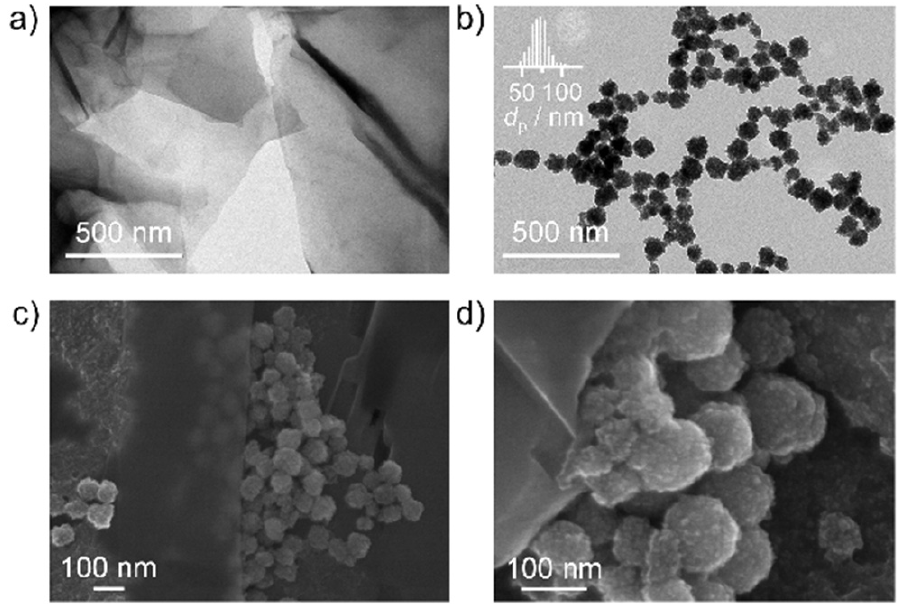
Figure 1. TEM micrographs of the ( a ) rGO sheets and ( b ) clusters of Fe 3 O 4 - γ Fe 2 O 3 nanoparticles. Panels ( c , d ) correspond to SEM images of the Fe 3 O 4 - γ Fe 2 O 3 /rGO hybrid. The XRD results of the samples are compiled in Figure 2a. The diffractogram of rGO displays a broad peak at 2 θ = 25 ◦ that corresponds to the (002) plane. Clusters of Fe 3 O 4 - γ Fe 2 O 3 nanoparticles are composed of crystallites of small sizes whose crystalline structure corresponds to either magnetite (Fe 3 O 4 ), maghemite ( γ -Fe 2 O 3 ), or a mixture of them, as both iron oxides present the same spinel structure (on which Fe 3+ or Fe 2+ cations or Fe 3+ cations and vacancies are arranged, respectively). Similarly, these diffraction peaks along with the broad band between 20 ◦ and 30 ◦ associated with rGO are detected in the hybrid structure. Indeed, the intensity of the latter is quite low, which might be due to its highly disordered structure because of oxidation and the low content. In order to shed light on the nature of the iron oxide species in the samples, we completed the structural analysis using Raman spectroscopy (Figure 2b). This technique enables us to register the different vibrations of the crystalline lattice due to different cationic arrangements [38,39], and can therefore differentiate the two magnetic iron oxide phases. The Raman spectrum of the clusters of Fe 3 O 4 / γ -Fe 2 O 3 nanoparticles displays four main bands, which can be associated to the A 1g vibration mode of the magnetite (at 668 cm − 1 ) and three broad bands centered at 350 cm − 1 , 500 cm − 1 , and 700 cm − 1 , corresponding to the T 2g , E g , and A 1g modes of maghemite, respectively [40–42]. Other characteristic features of the synthesized material, such as the black coloration of the powders and their strong interaction with external magnetic fields, were also observed. In the case of the rGO-based hybrids, the Raman spectrum displays the two characteristic bands of rGO, i.e., D and G at 1348 cm − 1 and 1594 cm − 1 , respectively, along with the characteristic intensity band ca. 680 cm − 1 associated with the A 1g modes of the Fe 3 O 4 (668 cm − 1 ) and γ -Fe 2 O 3 (700 cm − 1 ) magnetic